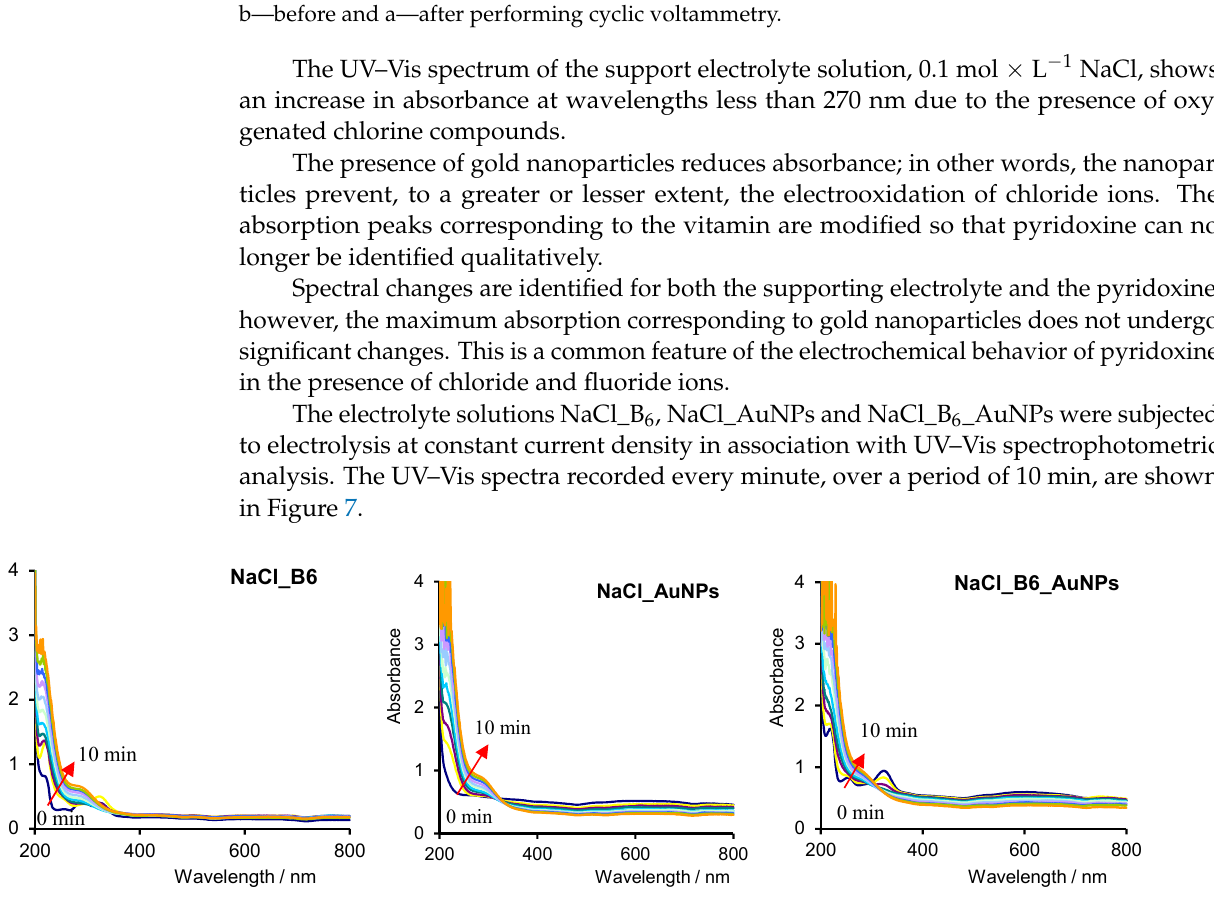
Figure 6. UV–Vis absorption spectra of electrolyte solution containing NaCl/B 6 /AuNP systems; b—before and a—after performing cyclic voltammetry.